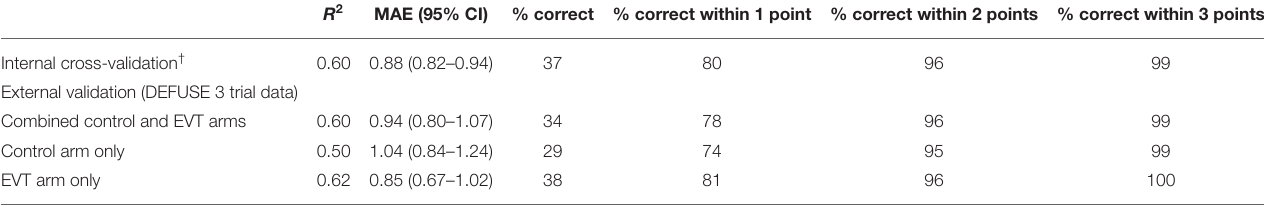
TABLE 3 | Performance metrics of the 90-day mRS prediction model in internal and external validation. R 2